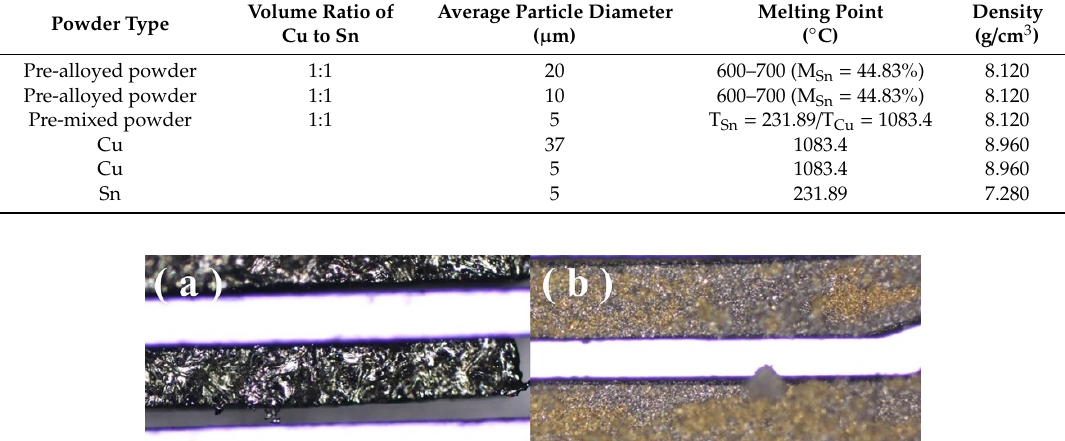
Figure 4. Sample after sintering of the 37 µm Cu powder mixed with 5 µm Sn powder in the through- trench. ( a ) Copper was observed to occupy most of the field on the upper surface and ( b ) a distinct stratification can be seen on the side. There are many factors that cause the powder segregation effect: the properties of particles, such as size, shape, density, elasticity, and roughness; the environment of the particle bed, such as the shape of the vessel, the filling depth, the gap fluid, and the temperature and humidity. Moreover, there are also different mechanisms proposed for this phenomenon, including void filling, density- driven phenomena, inertia, buoyancy, convection, geometric shapes of particles, and the influence of different frictions and interstitial media [22]. Thus, the segregation effect has strong inevitability and uncertainty [23–26]. Therefore, pre-alloyed powder with a specific particle composition (M Sn = 44.83% and M Cu = 55.17%) was selected for this experiment, with a melting point of approximately 650 °C according to the copper–tin phase diagram [27]. Each particle in the pre-alloyed powder contains various metal elements of the alloy, which is more uniform than that obtained by mechanically mixing multiple single metal powders. In the sintering process, no segregation or melting of low- melting-point metals occurs first, so it is widely used in the powder metallurgy industry [28–30]. In addition to temperature, powder size is one of the parameters affecting sintering conditions in conventional sintering [31–34]. To verify whether diameters of the powders will affect the performance of the microstructures, two pre-alloyed powders with different diameters were selected. It was necessary to ensure that the powder used in the experiment experiences no oxidation, because if oxidation occurs, the melting point will increase greatly. 3. Results and Discussion A complete in-chip 3D coil can be obtained after finishing the process flow. Figure 5 depicts the ( a ) upper and ( b ) lower surfaces of a Cu-Sn pre-alloyed powder-filled chip after surface lapping cleaning. Figure 6 shows the pre-mixed powder trench structure at different magnifications, and Figure 7 shows the trench filled with pre-alloyed powder. The filling condition of pre-alloyed powder was observed to be much more uniform, indicating that the sintering effect could be good. After removing the silicon structure, a 3D coil could ultimately be obtained.